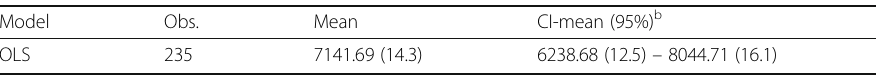
Table 5 Summary statistics of monthly mean WTP bid a